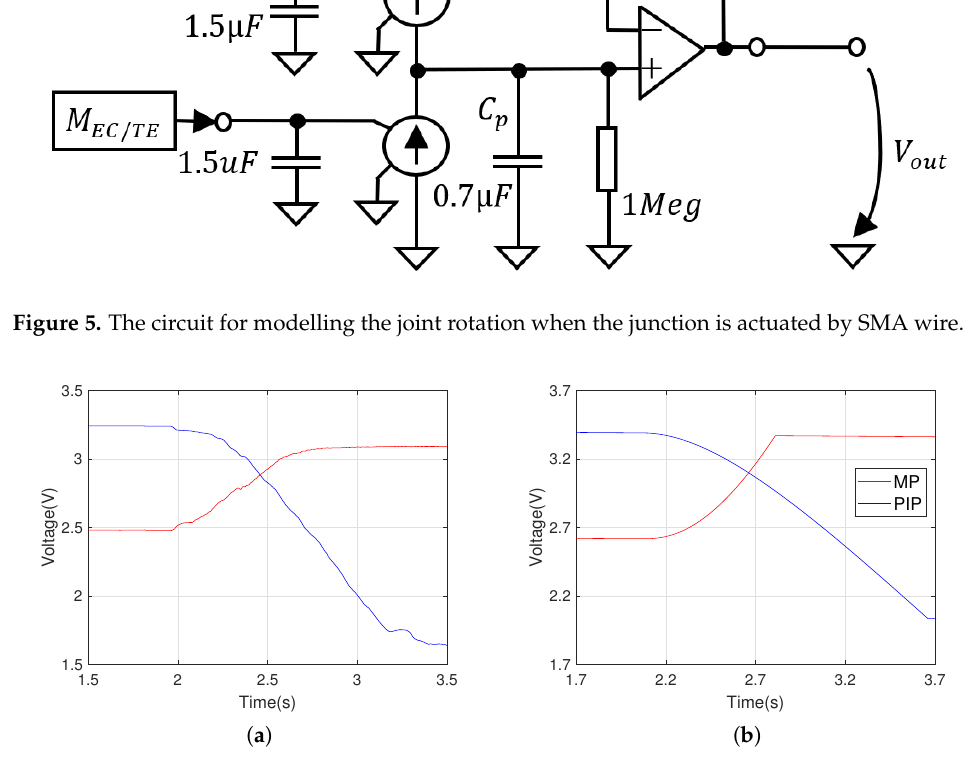
Figure 6. The similarity between ( a ) the output of the flex sensors when the finger is actuated by microcontroller and ( b ) the output of the circuit SMC that models the rotation of the robotic joint when actuated by the